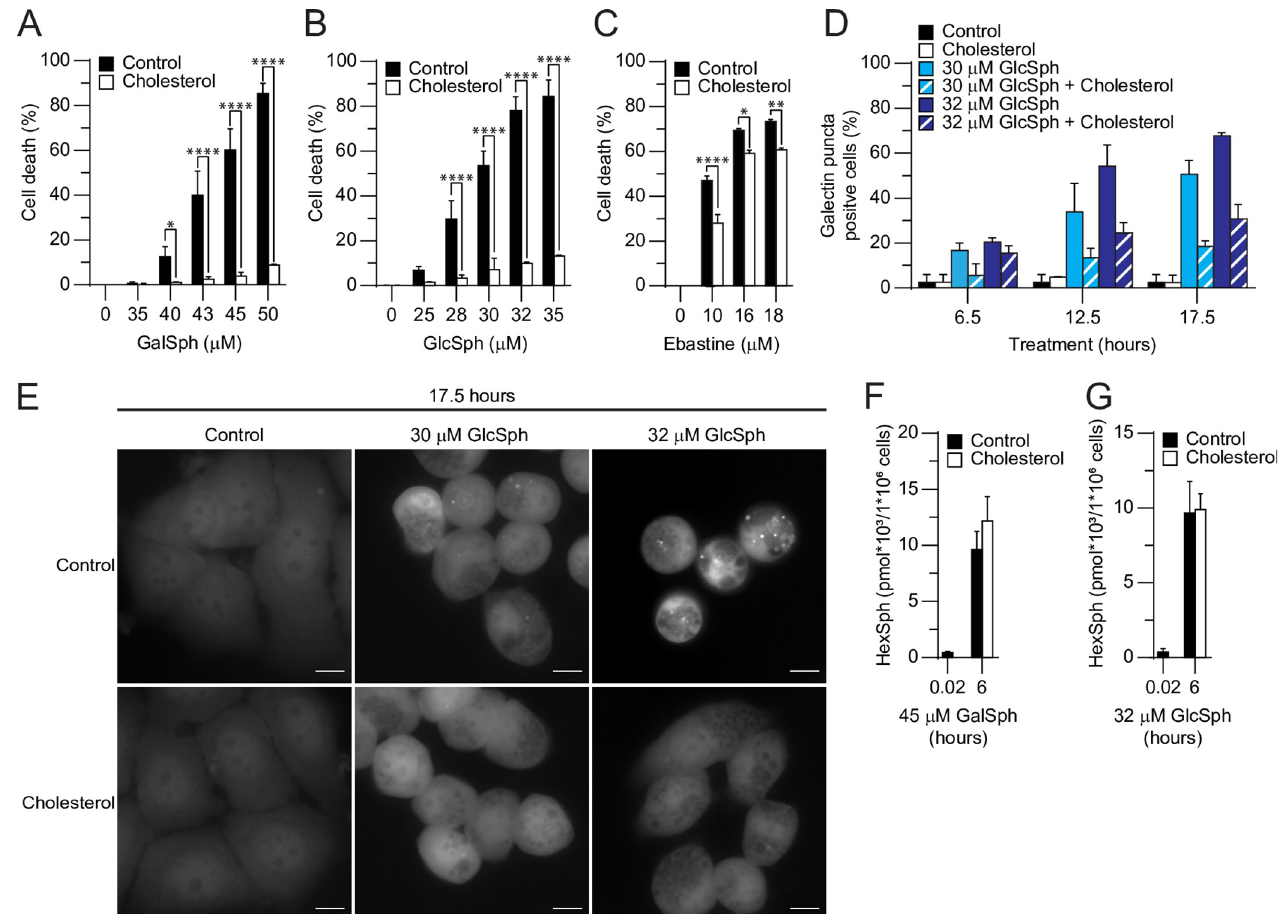
Fig 6. Cholesterol inhibits cell death induced by GalSph and GlcSph in MCF7 cells. (A-C) Death of MCF7 cells treated for 48 hours with indicated concentrations of GalSph (A), GlcSph (B), or ebastine (C) was determined as in Fig 1A. When indicated, 60 μ M cholesterol was added 24 hours before the addition of lysosphingolipids or CADs. (D) Percentage of galectin-3 puncta positive MCF7 galectin-3-eGFP cells treated as indicated with GlcSph and visualized as in (E). When indicated, 60 μ M cholesterol was added 24 hours before the addition of lysosphingolipids (n = 2). (E) Representative images of MCF7 galectin-3-eGFP cells treated with indicated concentrations of GlcSph, for 17.5 hours were acquired using the ImageXpress ( FITC channel). When indicated, 60 μ M cholesterol was added 24 hours before the addition of GlcSph. Scale bars, 10 μ m (F-G) Quantities of HexSph (GalSph and GlcSph) in lysates of MCF7 cells treated with 45 μ M GalSph (F) or 32 μ M GlcSph (G). When indicated, 60 μ M cholesterol was added 24 hours before the addition of lysosphingolipids. Error bars, SD of three independent experiments. � , P < 0.05; �� , P < 0.01; ���� , P < 0.0001 as analyzed by two-way ANOVA followed by Sidak’s multiple comparisons